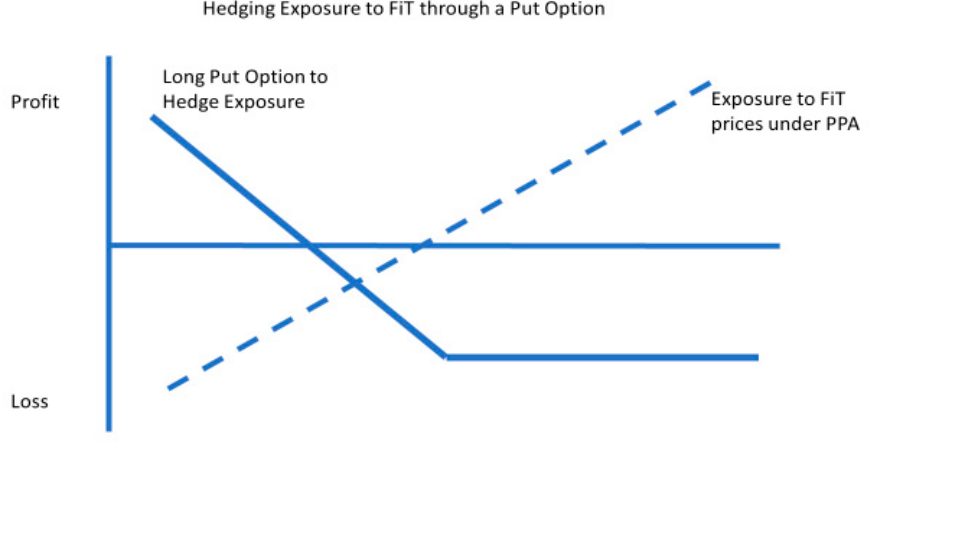
Figure 1. Stylized pay-offs diagram for hedging with put option.